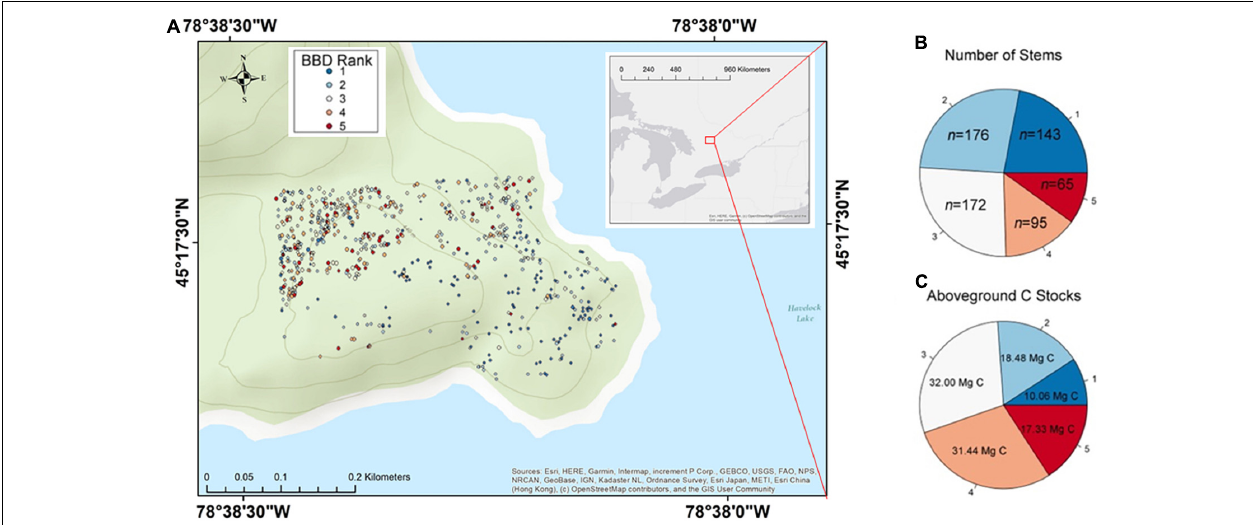
FIGURE 1 | Spread of beech bark disease (BBD) throughout the Haliburton Forest Dynamics Plot. Panel (A) shows the site and locations of all beech trees included in study over a topographic map. An overview map defining the location of the study site within the larger context of North America is also provided in Supplementary Figure 1 . Panel (B) displays the number of stems that belong to any given BBD symptom ranking. Panel (C) displays the amount of carbon (C) estimated to be associated within each BBD symptom